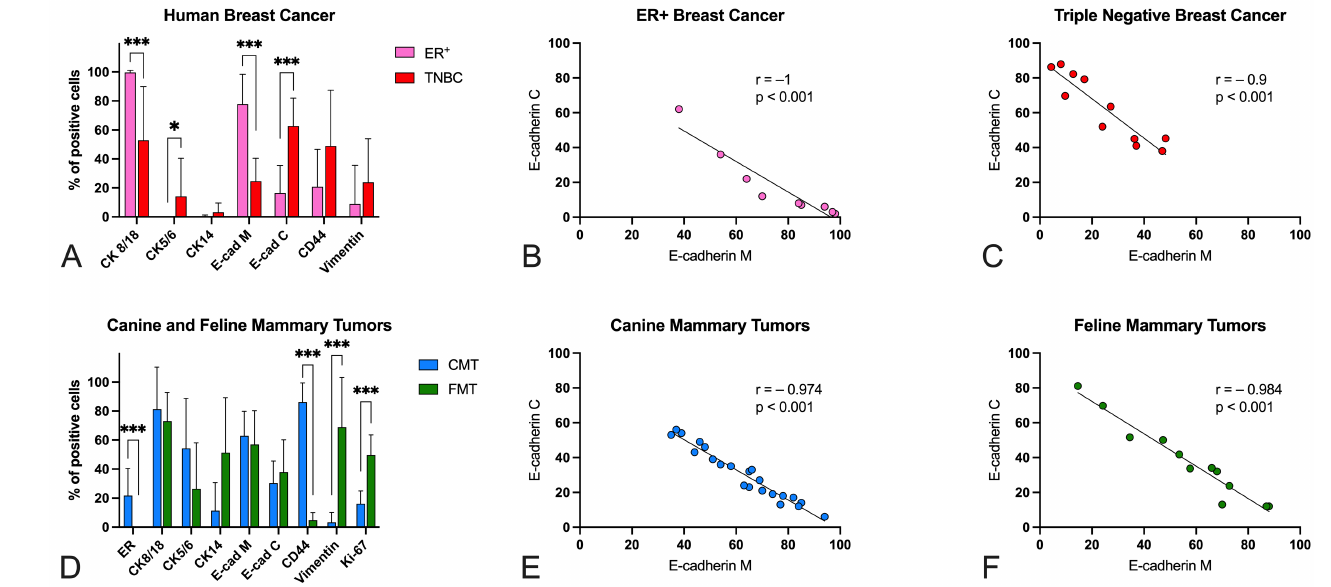
Figure 4. Immunohistochemistry results for cytokeratin (CK) 8/18, CK5/6, CK14, membranous E-cadherin (E-cad M), cytoplasmic E-cadherin (E-cad C), CD44, vimentin in estrogen receptor-positive (ER+) and in triple-negative breast cancers (TNBCs) ( A ). CK8/18 and membranous E-cadherin expression was lower in TNBCs than in ER+. CK5/6 and cytoplasmic E-cadherin expression was higher in TNBCs than in ER+. A strong negative correlation between membranous and cytoplasmic E-cadherin expression was found in ER+ ( B ) and in TNBCs ( C ). Immunohistochemistry results for ER, CK8/18, CK5/6, CK14, E-cad M, E-cad C, CD44, vimentin, and Ki-67 in canine (CMTs) and feline mammary tumors (FMTs) ( D ). ER and CD44 protein expression was lower in FMTs than in CMTs. Vimentin and Ki-67 expression was higher in FMTs than in CMTs. A strong negative correlation between membranous and cytoplasmic E-cadherin expression was found in CMTs ( E ) and FMTs ( F ). * p < 0.05; *** p < 0.001.